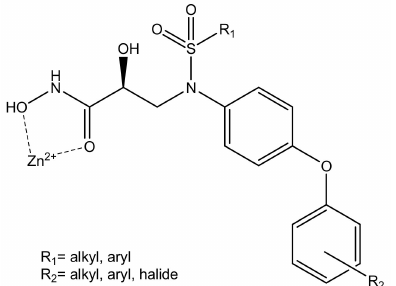
Figure 8. General structure of zinc chelators [44].